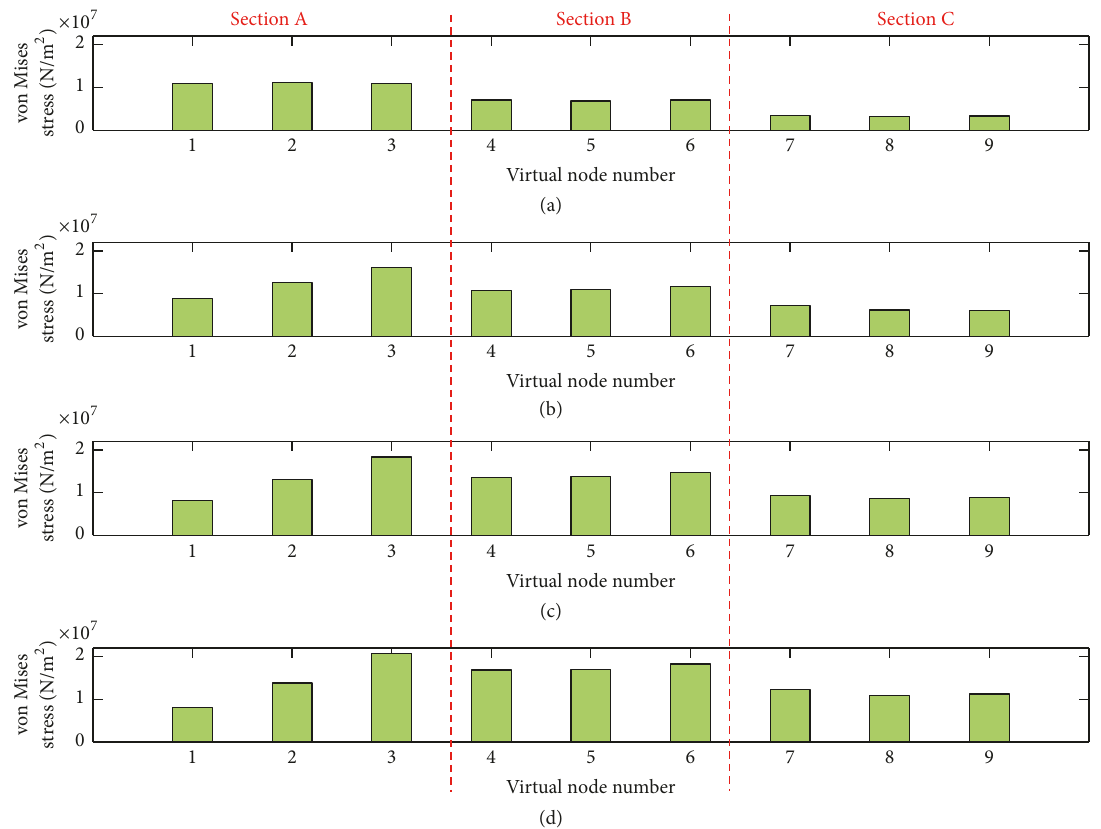
Figure 7: von Mises stresses from numerical simulation: (a) conventional system; (b) Hole 1; (c) Hole 2; (d) Hole